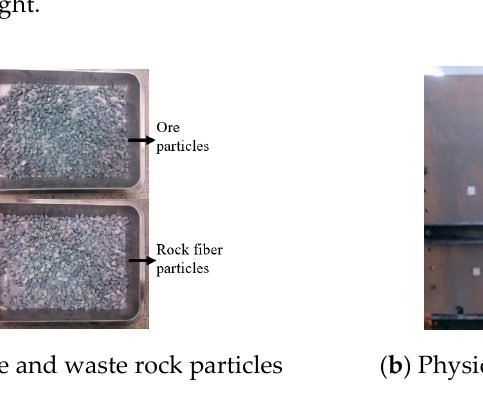
Figure 14. Physical ore drawing model. ( a ) Ore and waste rock particles; ( b ) Physical drawing model